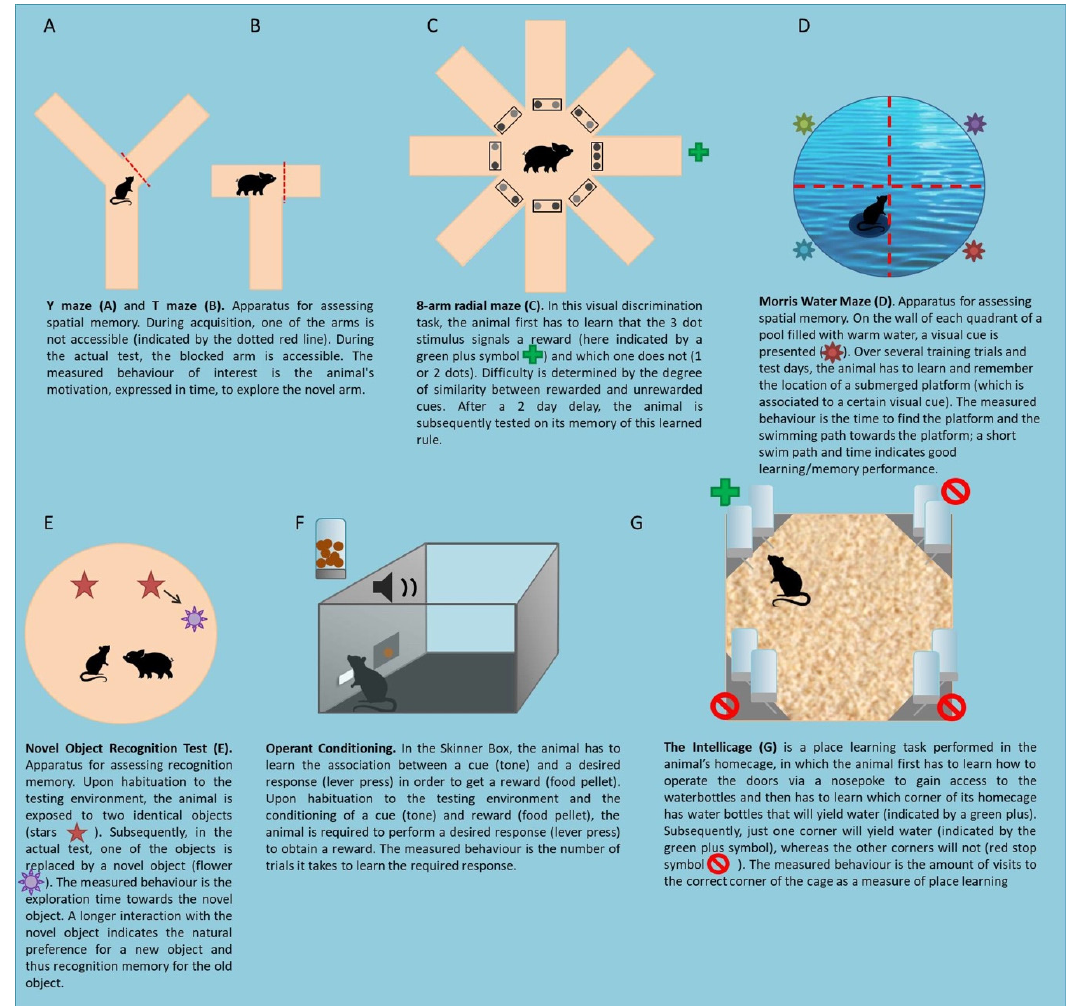
Figure 1. Summary of the behavioural tests used in the HMO studies. The type of animal placed inside the test (rodent or piglet) corresponds to the animal model used in the behavioural paradigms included in this review .